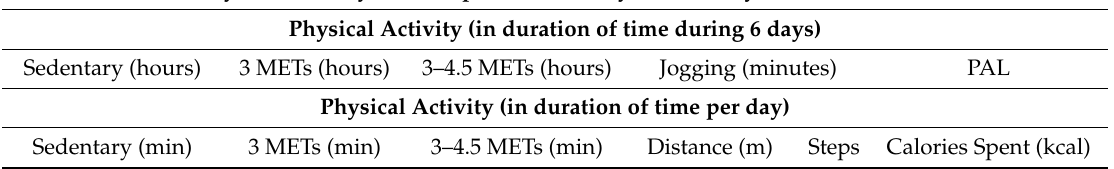
Table 1. Description of physical activity (hours, steps, METS, distance). The figure includes the parameters as distance, time, intensity, and Physical Activity Level (PAL) as expression of mean amount degree of daily physical activity. All these parameters are used to classify the lifestyle of the patients, just in case accelerometry is